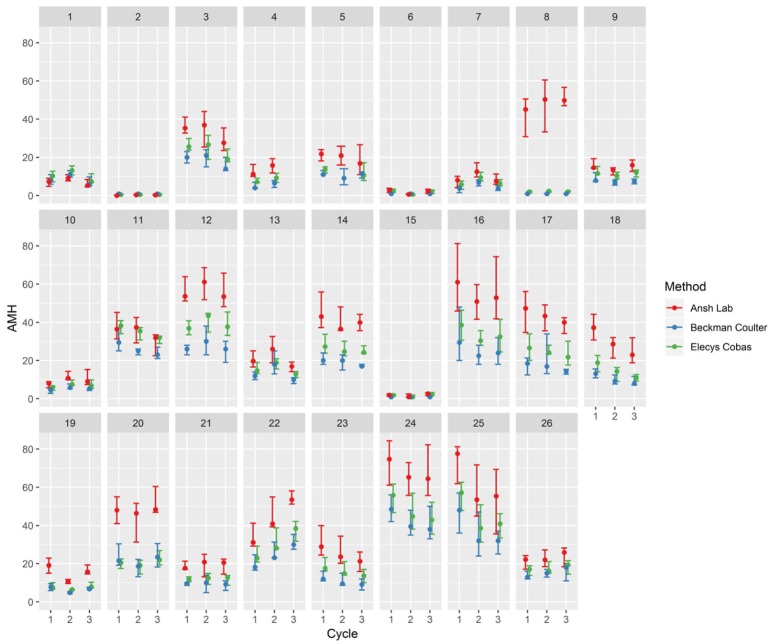
Median and range of AMH in three consecutive cycles with AMH measured cycle-day 5–10–15–20–25 at three analyzing platforms.